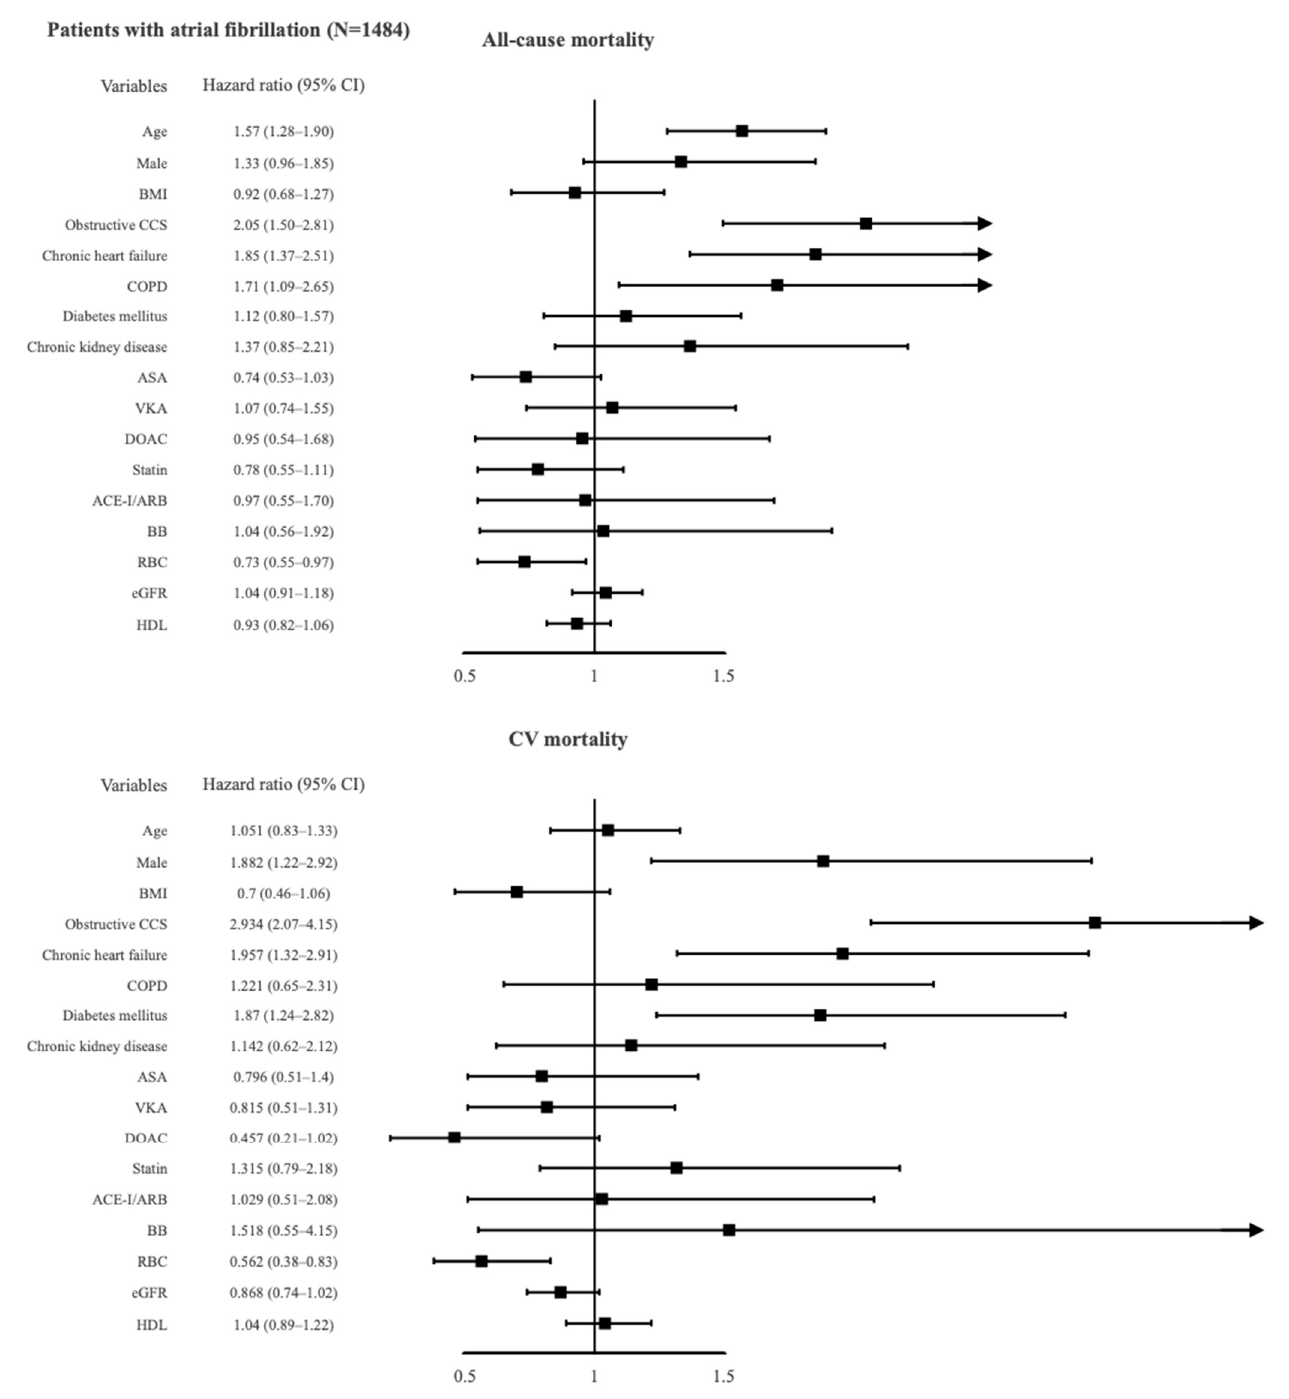
Figure 4. Predictors of all-cause and cardiovascular mortality in patients with atrial fibrillation using multivariate analysis. ACEI, angiotensin-converting-enzyme inhibitor; ARB, angiotensin receptor blocker; ASA, acetylsalicylic acid; BB, beta adrenergic receptor antagonist; BMI, body mass index; CCS, chronic coronary syndrome; COPD, chronic obstructive pulmonary disease; CV, cardiovascular; DOAC, direct oral anticoagulant; eGFR, estimated glomerular filtration rate; HDL, high-density lipoprotein cholesterol; RBC, red blood cells; VKA, vitamin K